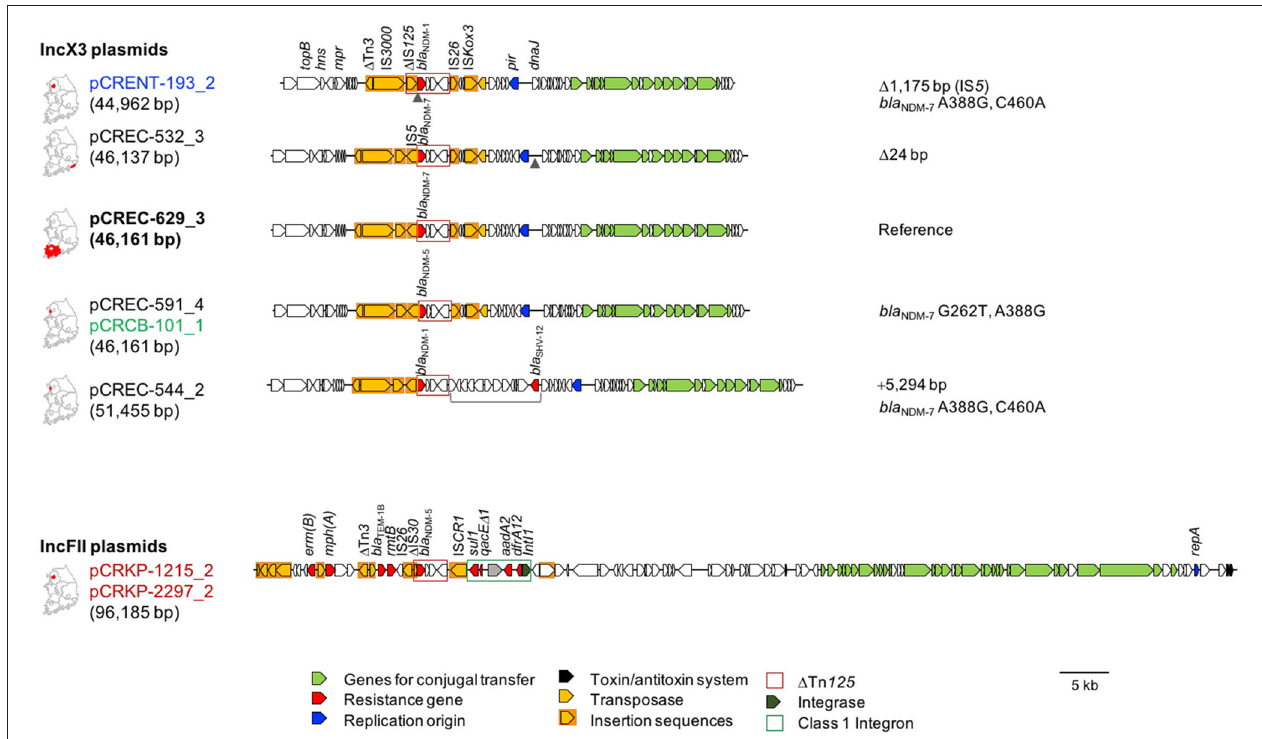
FIGURE 1 | Schematic representation of the bla NDM -harboring IncX3 and IncFII plasmids. Name of the plasmids and the size in parenthesis are denoted for the plasmids, and the district of isolation are indicated on the map of Korean peninsula in front of the plasmid name. Name of the plasmids from E. coli are indicated in black, from Enterobacter spp. in blue, and from K. pneumoniae in red. Open arrows indicate coding sequences for conjugal transfer (light green), drug resistance (red), replication origin (blue), toxin/antitoxin system (black), transposase (yellow), and integrase (green). Insertion sequences are indicated in yellow boxes. The Tn 125 is marked with a red-bordered open box, and the class 1 integron is indicated with a green-bordered open box. Genetic variants of each plasmid referred by pCREC-629_3 are indicated on the right side of the schematic representation of the plasmid for locating the point of substitution: arrowheads, deletion; square bracket, insertion. Together with the nt substitutions, details of insertion are indicated with + , and that of deletion with 1 in the end of the schematic presentation of the plasmid.